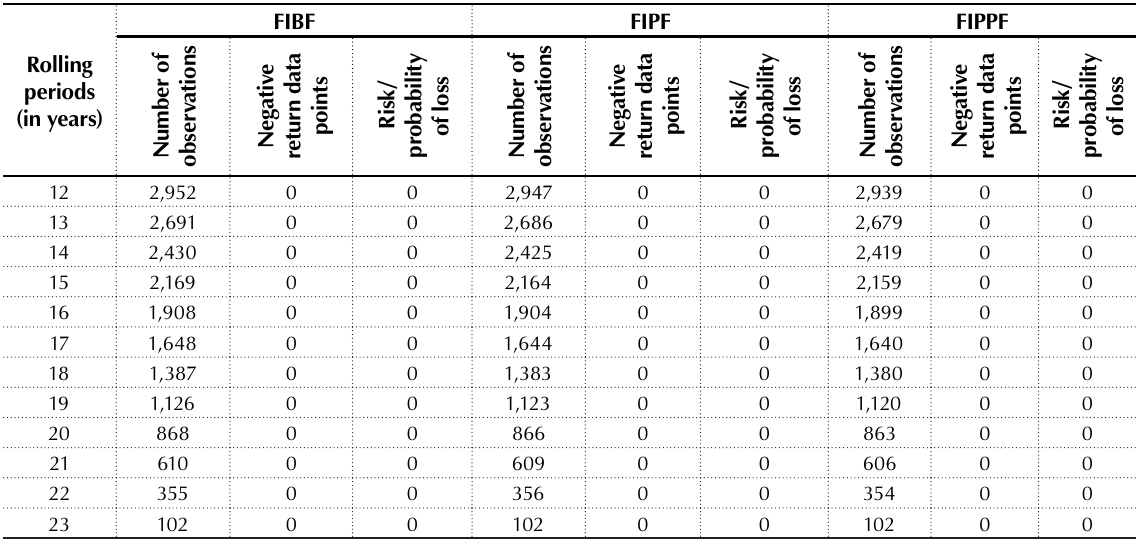
Table 13. Rolling period risk and return behavior of ABSLEH95F, HDFCCBVF and SBIEHF (1995–2018)